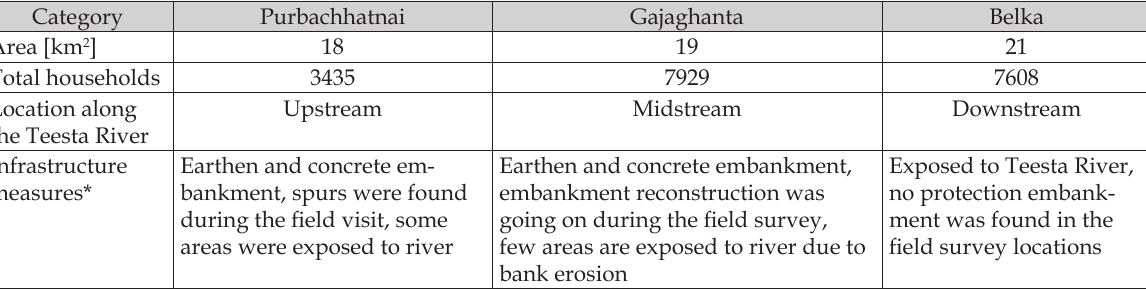
Table 2. Key characteristic of the surveyed locations, year